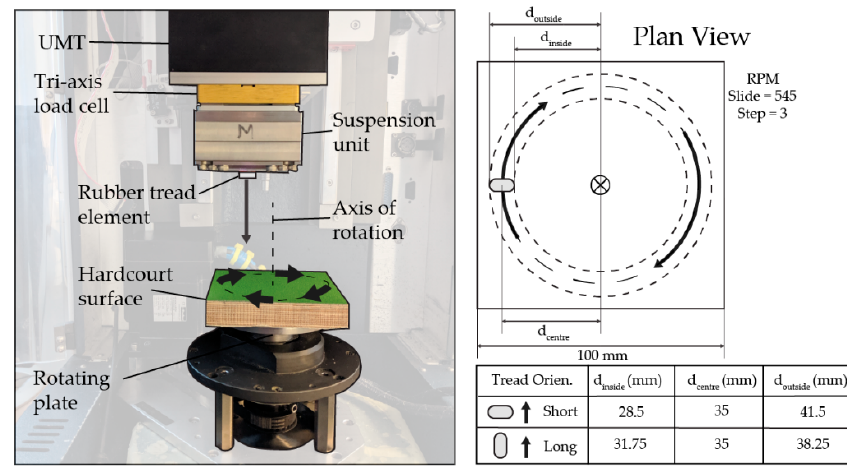
Figure 3. The experimental set-up.